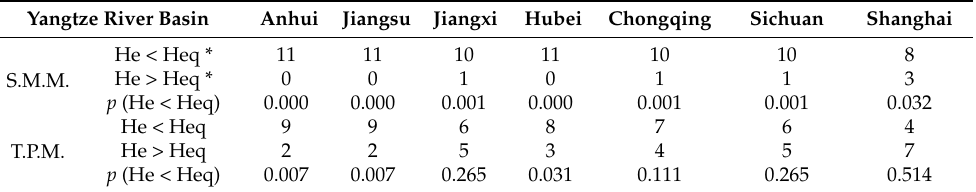
Table 4. Heterozygosity tests of 22 Ae. albopictus populations among seven locations based on the stepwise mutation model (S.M.M.) and two-phase model